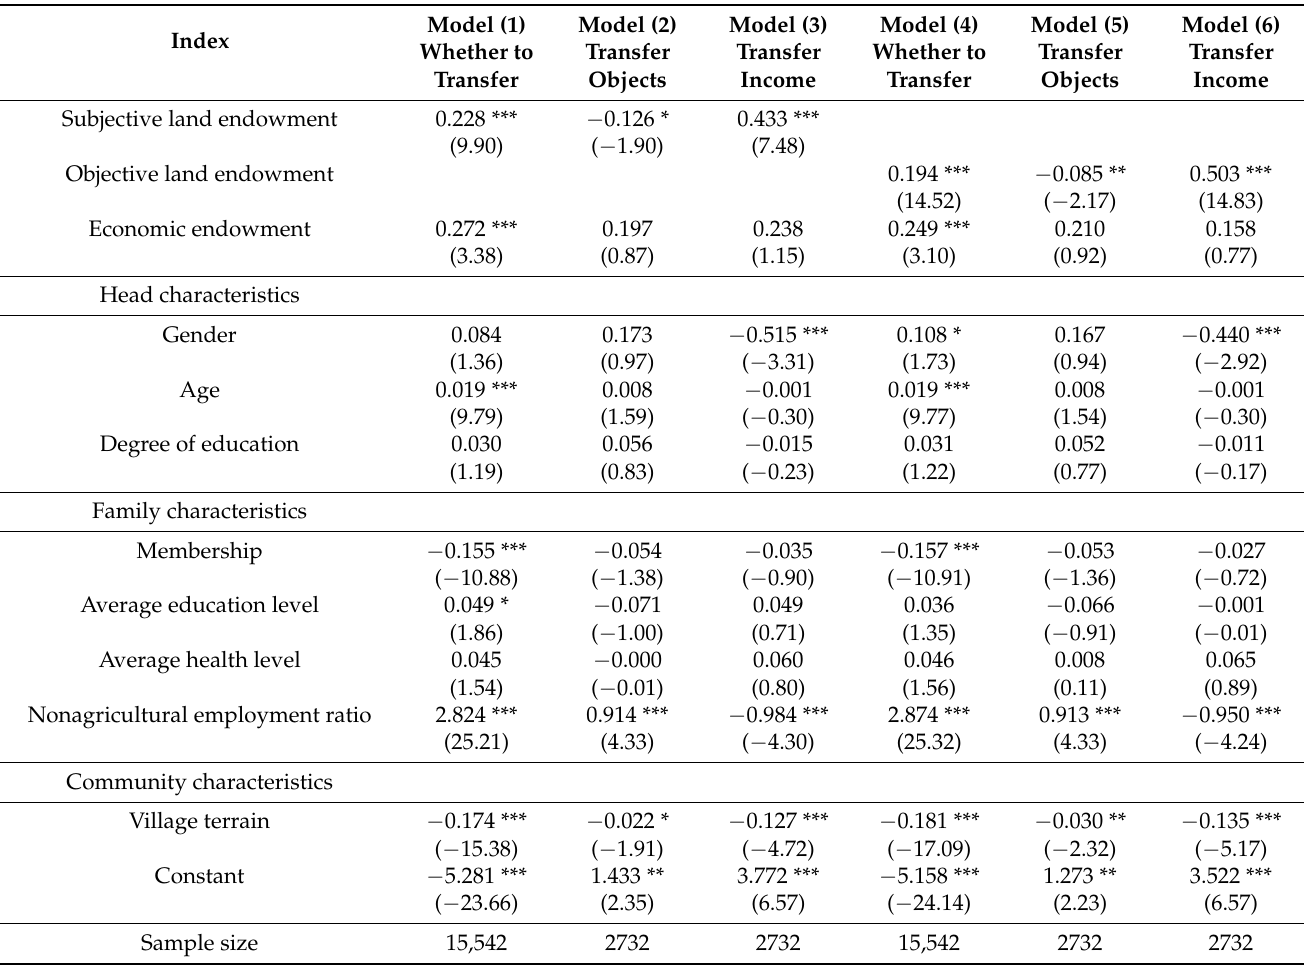
Table 3. Impact analysis of land